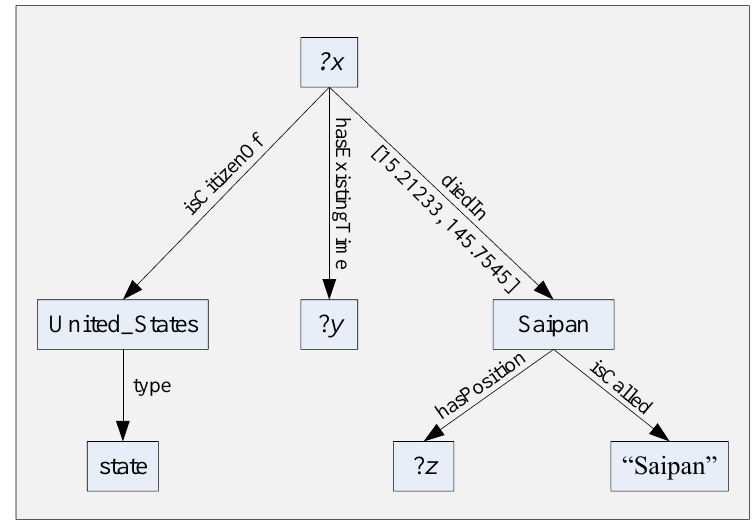
Figure 4. Spatiotemporal RDF query graph.